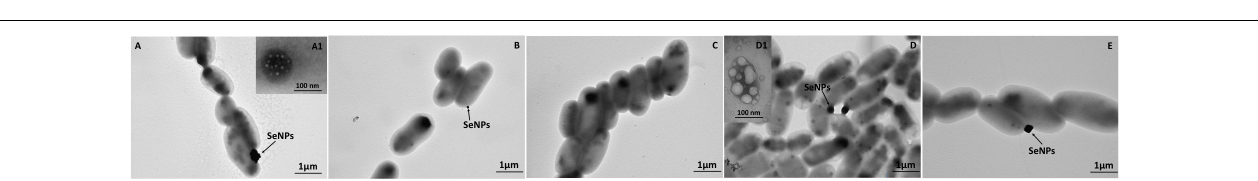
FIGURE 4 | Time course imaging by TEM of Ochrobactrum sp. MPV1 strain grown in DM amended with glucose (0.5% v/v) and SeO 2 − 3 (0.5 mM) for 24-h (A) , 48-h (B) , 72-h (C) , 96-h (D) , and 120-h (E) . The inlets (A1–E1) show enlargements of intracellular SeNPs and nanorods (SeNRs), which are indicated by black arrows.